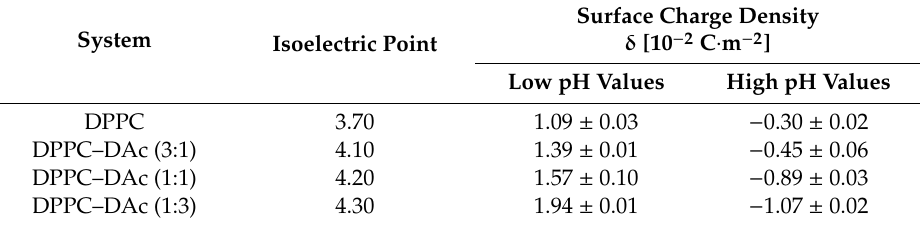
Table 4. Membrane surface charge densities and isoelectric points for the DPPC-DAc